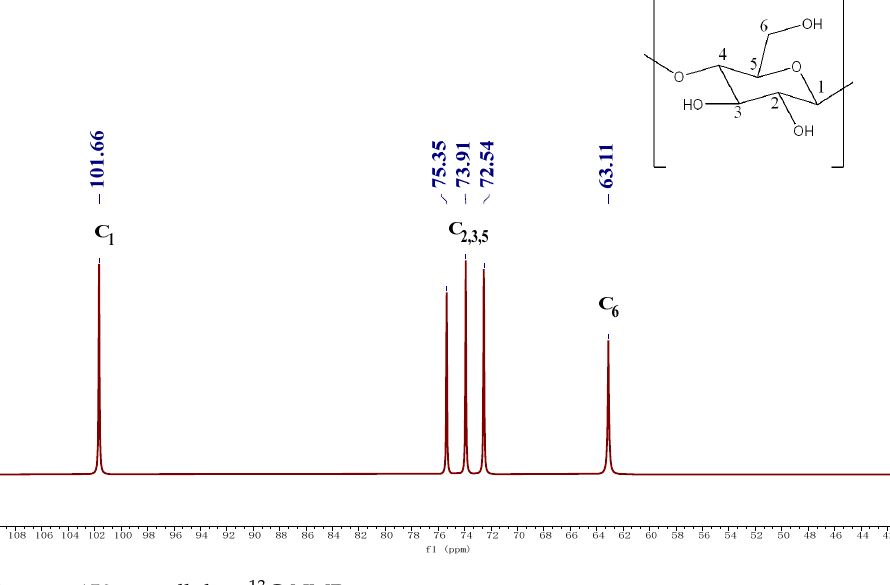
Figure 6. 150 μ m cellulose 13